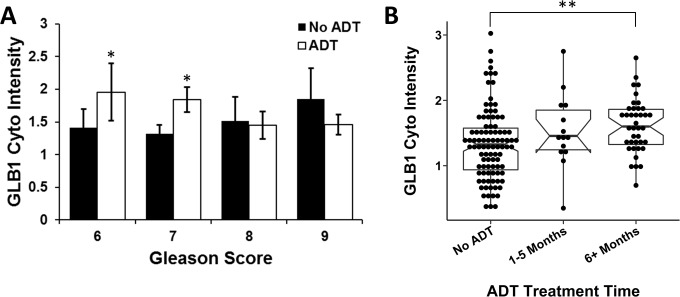
GLB1 levels increase after ADT in intermediate grade PCa and over time.(A) GLB1 expression was measured in radical prostatectomy specimens categorized by ADT status and pretreatment Gleason grade. Higher levels of GLB1 were expressed in intermediate PCa tissues treated with ADT. GLB1 after ADT was not increased in high grade cancers (Gleason 8 + 9). (B) GLB1 expression was evaluated over neoadjuvant ADT treatment duration. PCa tissues exposed to ADT longer than 5 months expressed significantly higher levels of GLB1 compared to no ADT, but shorter durations of ADT exposure did not reach significance. (*p<0.05;**p<0.01; mean±SE).